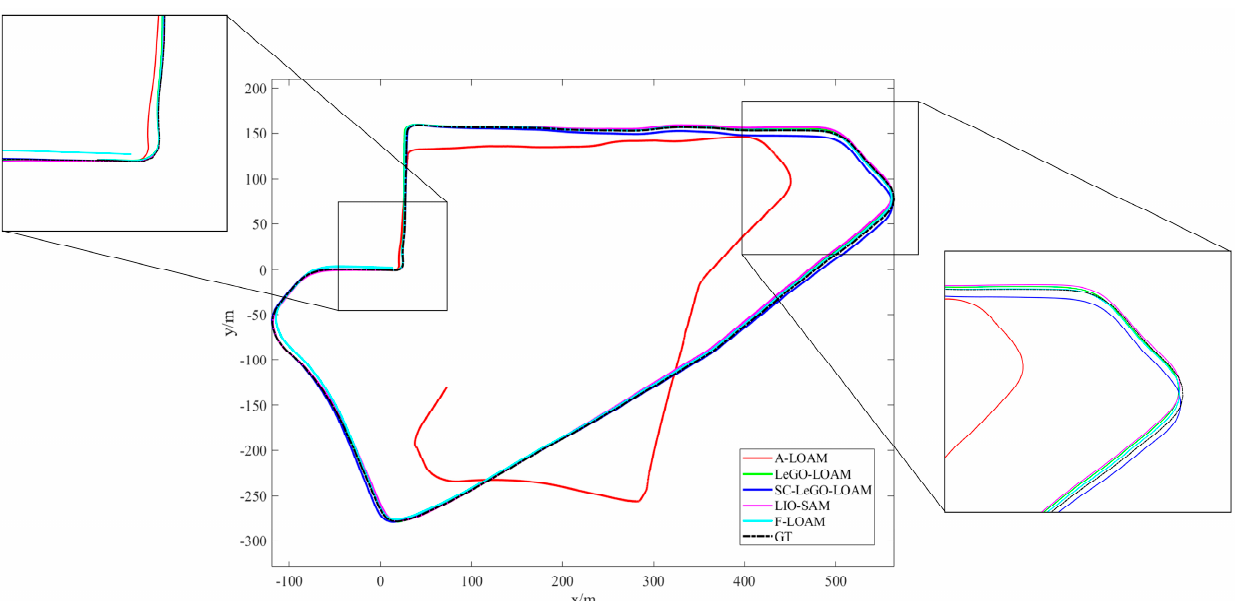
Figure 10. Trajectories generated by different algorithms. The first occurrence of the closed loop and the farthest distance from the closed loop are zoomed in for a closer comparison of their differences.